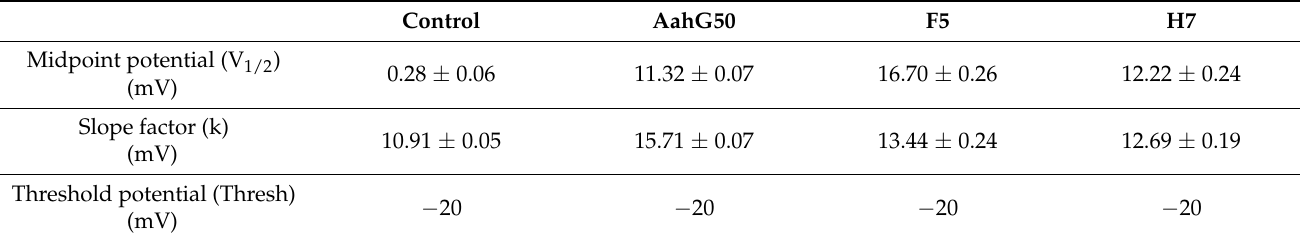
Table 1. Analysis of AahG50, F5 and H7 on hKv3.1 channel activation